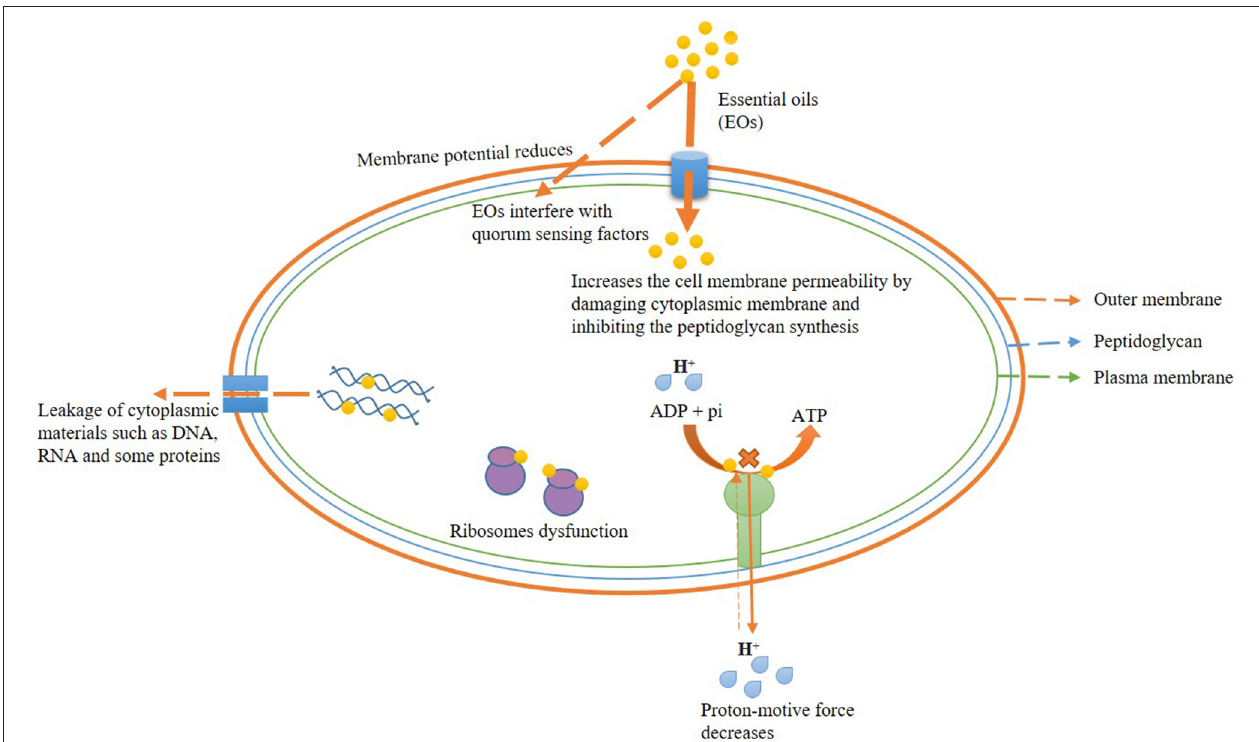
FIGURE 1 | Possible antibacterial mechanism of action of essential